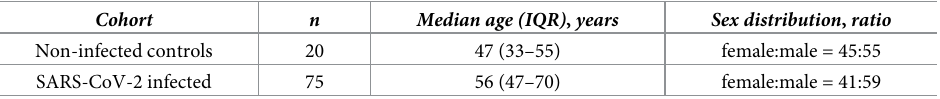
Table 1. Number of samples (n), median age, and sex distribution of non-infected controls and SARS-CoV-2 infected patients (IQR, interquartile range).